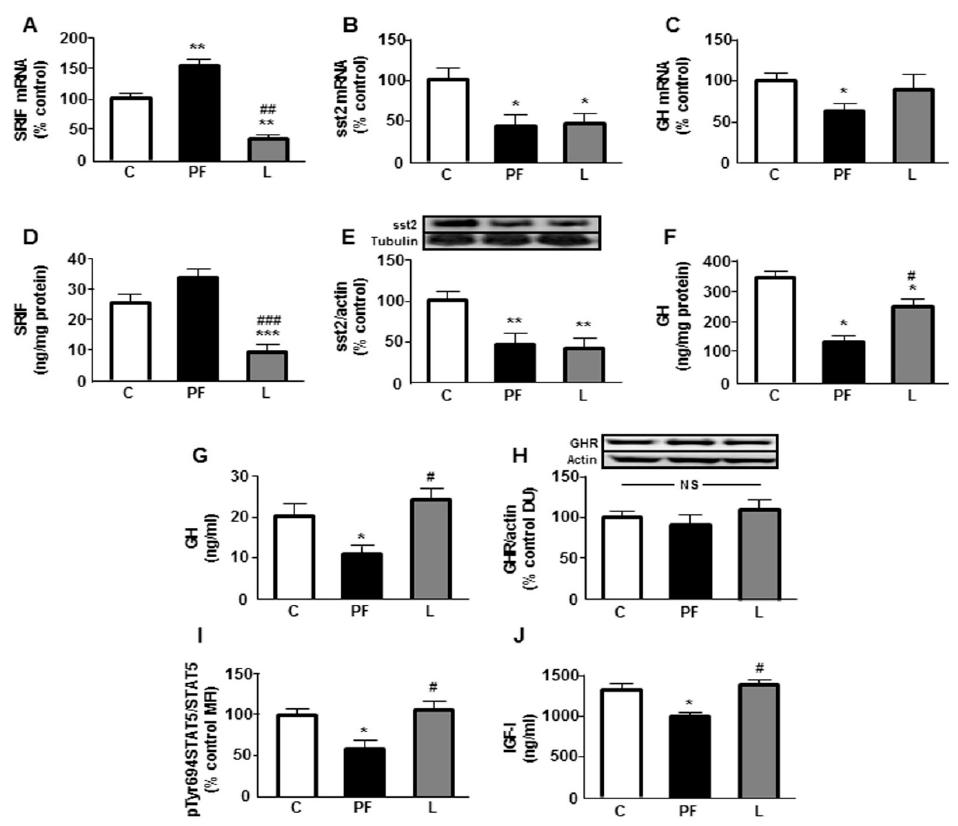
Figure 1. Effects of central leptin infusion on the growth hormone (GH)/insulin-like growth factor I (IGF-I) axis. ( A ) Relative hypothalamic somatostatin (SRIF) mRNA content, ( B ) pituitary somatostatin receptor subtype (sst)2 mRNA content, ( C ) pituitary GH mRNA content, ( D ) SRIF protein levels in the hypothalamus, ( E ) sst2 relative protein levels in the pituitary, ( F ) GH protein levels in the pituitary, ( G ) serum GH concentration, ( H ) GH receptor (GHR) protein levels in the liver, ( I ) protein levels of signal transducer and activator of transcription (STAT)5 phosphorylated (p) at Tyr694 (pTyr694STAT5) in the liver and ( J ) serum IGF-I concentrations in control rats (C), pair-fed rats (PF) and rats receiving a chronic icv leptin infusion (L). Data are presented as means ± SEM. N = 5. DU, densitometry units; MFI, median fluorescent intensity; NS, non-significant. * p < 0.05, ** p < 0.01, *** p < 0.001 vs. C, # p < 0.05, ## p < 0.01, ### p < 0.001 vs. PF.